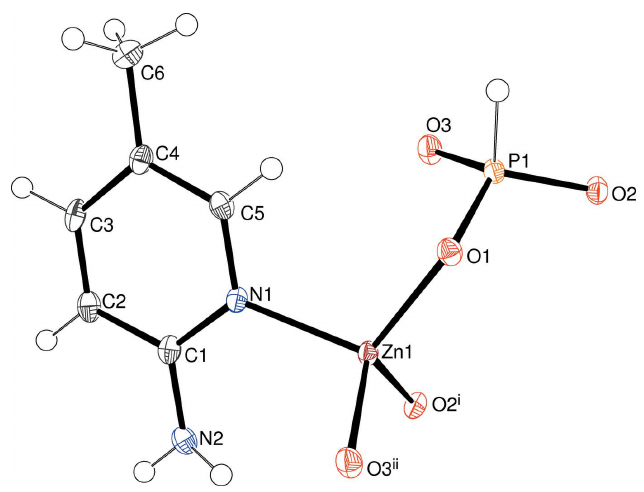
Figure 3 The asymmetric unit of (III) expanded to show the complete zinc-atom coordination sphere showing 50% displacement ellipsoids. Symmetry codes: (i) 1